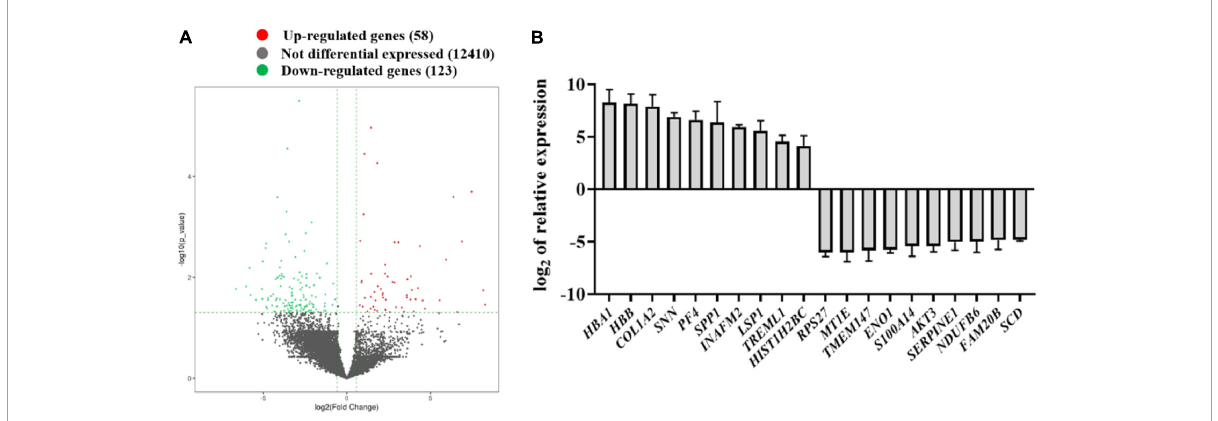
FIGURE1 Identification of the differentially expressed genes in the plasma from normal children and child patients with congenital talipes equinovarus (CTEV) using mRNA-seq. (A) Volcano plot of gene expression changes between control and child patients with CTEV. (B) Top 10 upregulated and downregulated genes from the RNA-seq